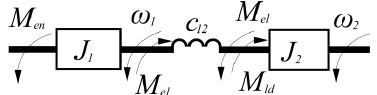
Fig. 4. Equivalent dual-mass system with elastic coupling